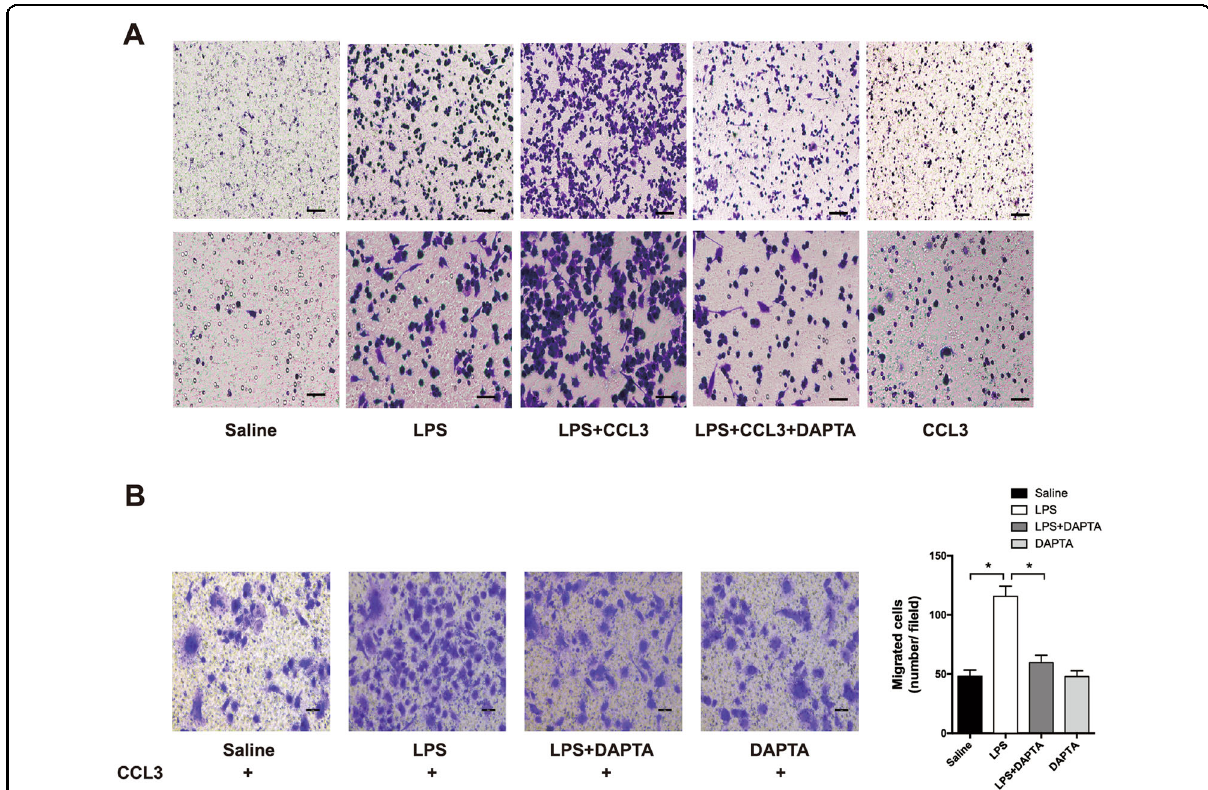
Fig. 4 Enhanced migration of macrophages induced by LPS toward CCL3. A Representative images of migrating RAW264.7 cells treated with LPS (1 µg/µl) and/or CCL3 (0.1 µg/µl), and DAPTA (1 µg/µl) for 12 h. Top: Scale bar: 100 μ m. Bottom: Scale bar: 50 μ m. B Representative images of migrating macrophages from BALF after treatment with LPS (1 µg) and/or DAPTA (1 μ g) for 72 h. Scale bar: 50 μ m. Quanti fi cation of transwell migrated macrophages. Data are expressed as mean ± SD ( n = 7), * p <